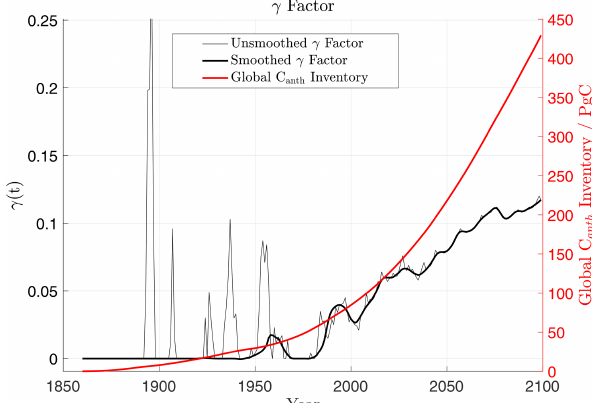
Figure C1. The calculated γ factor (thin black line), smoothed γ factor (thick black line), and global anthropogenic carbon inventory (red